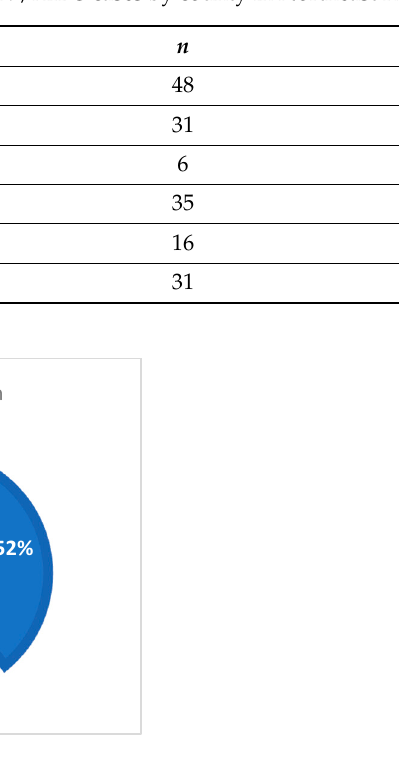
Table 2. Distribution of new HIV/AIDS cases by county in Northeast Romania.